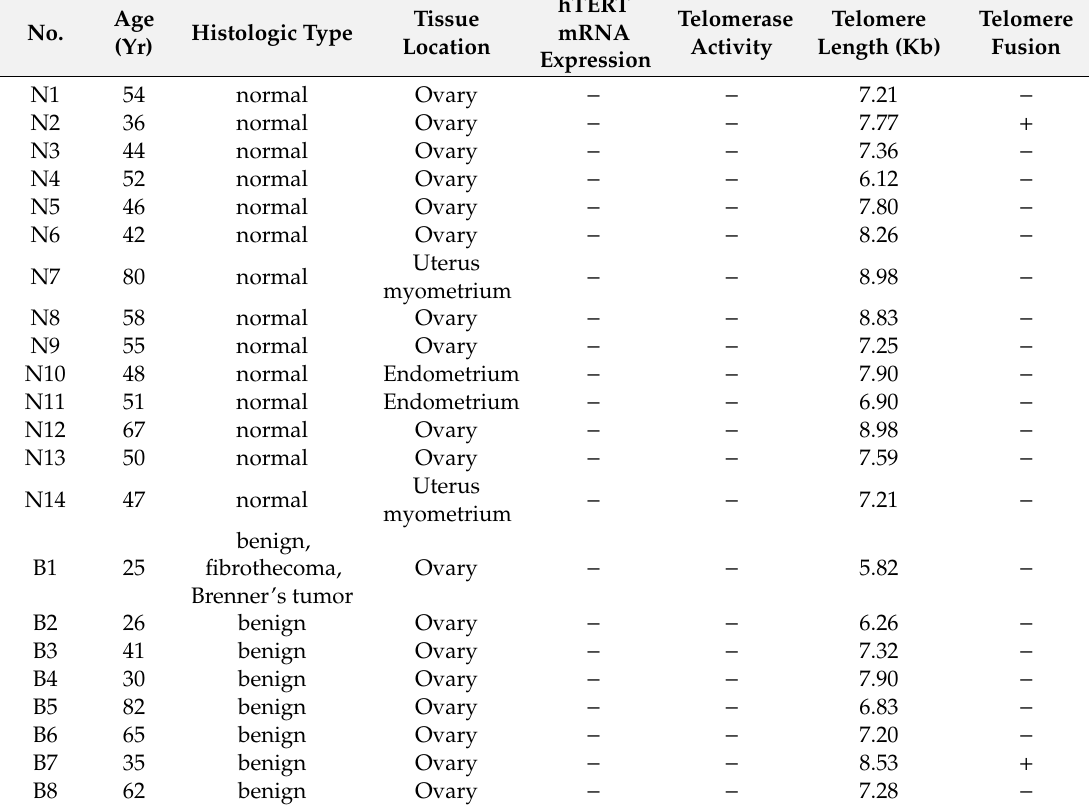
Table 1. Breakdown of patient samples received from IU Cancer Center Tissue Bank at the IU Simon Cancer Center. hTERT mRNA, telomerase activity, telomere length, and telomere fusion information from subsequent tests is